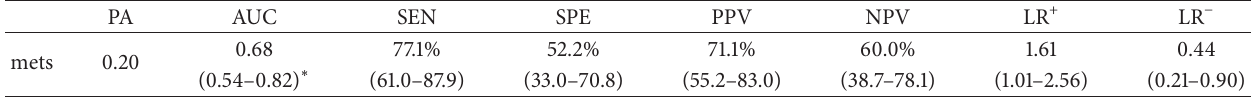
Table 4: Receiver operating characteristic (ROC) analysis and optimum cut-off point of prealbumin for predicting metastasis in patients with inoperable gastric adenocarcinoma.